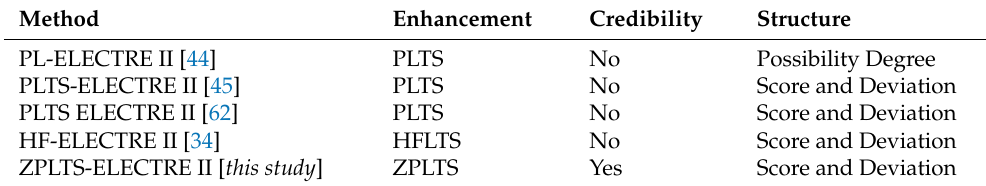
Table 30. Comparison of ZPLTS-ELECTRE II with other ELECTRE II